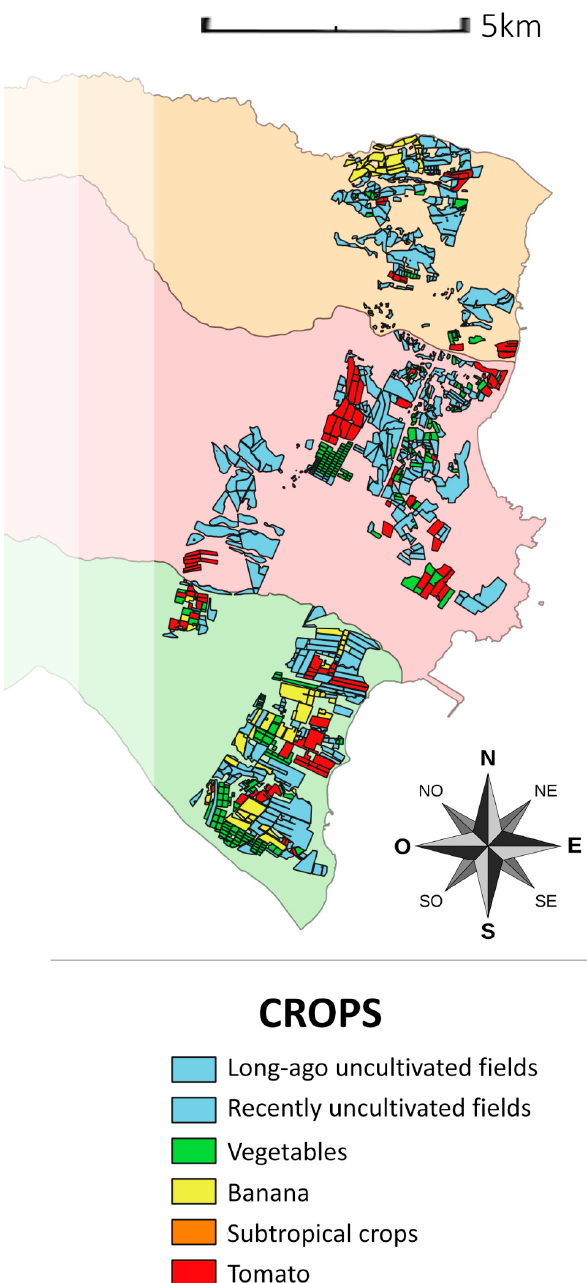
Figure 3. Crop strata in the Southeast of Gran Canaria below the reclaimed water network level for this study. Source: IDECanarias (https://visor.grafcan.es/visorweb/ on the 15 June 2018). Own elaboration.